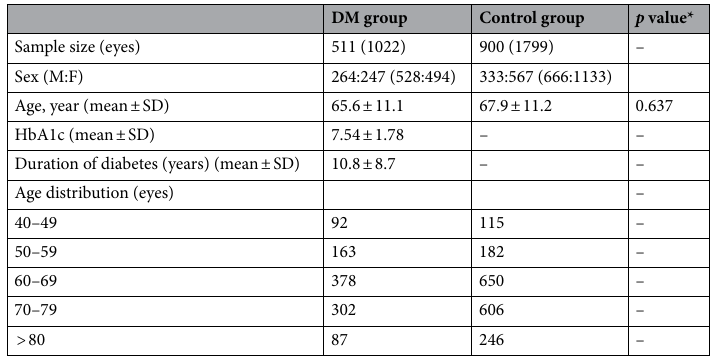
Table 1. Demographics and age distributions of diabetic and control groups. * p value by independent t-test.